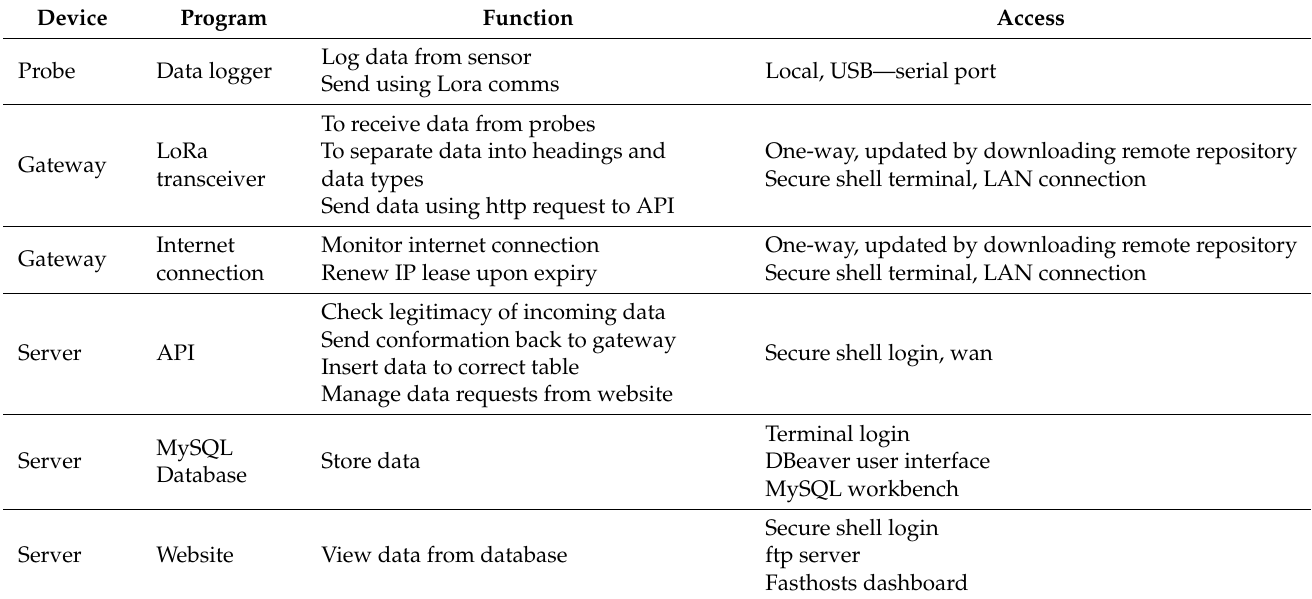
Table 2. Table summary of